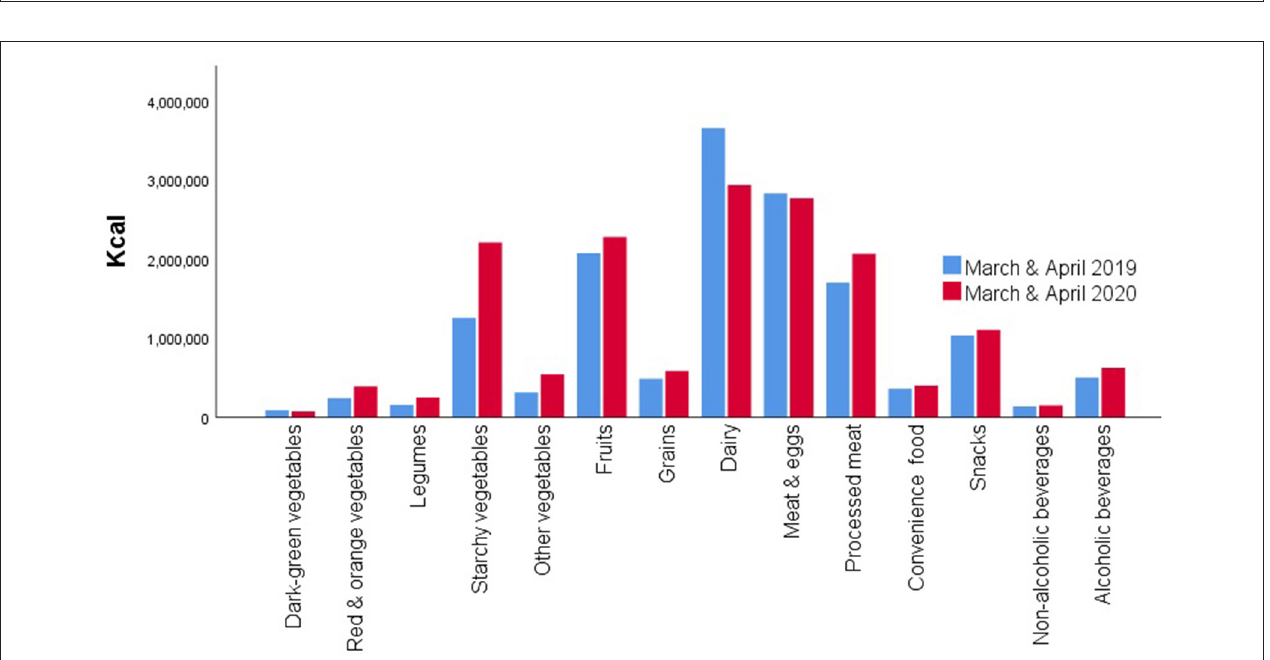
FIGURE 2 | Average monthly caloric value of sold items per food category in Kcal, comparing average total monthly caloric values of eight items per food category in March and April 2019 and March and April 2020 ( p = 0.26).